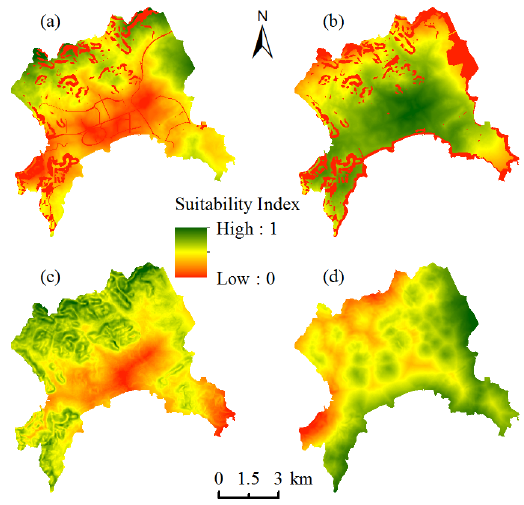
Figure 5. Suitability maps for: ( a ) agricultural land; ( b ) construction land; ( c ) forestland; and ( d ) water. Table 2. Weights of influencing factors of land suitability.